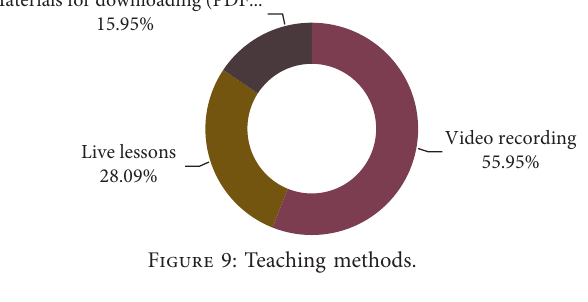
Figure 9: Teaching methods.